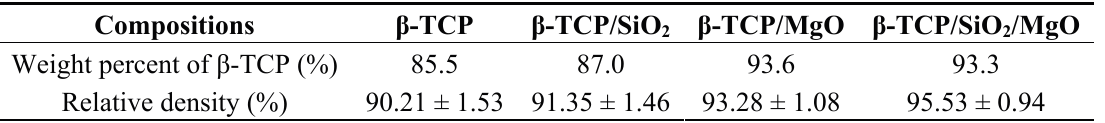
Table 1. Weight percents of β -tricalcium phosphate ( β -TCP) after sintering and relative densities of